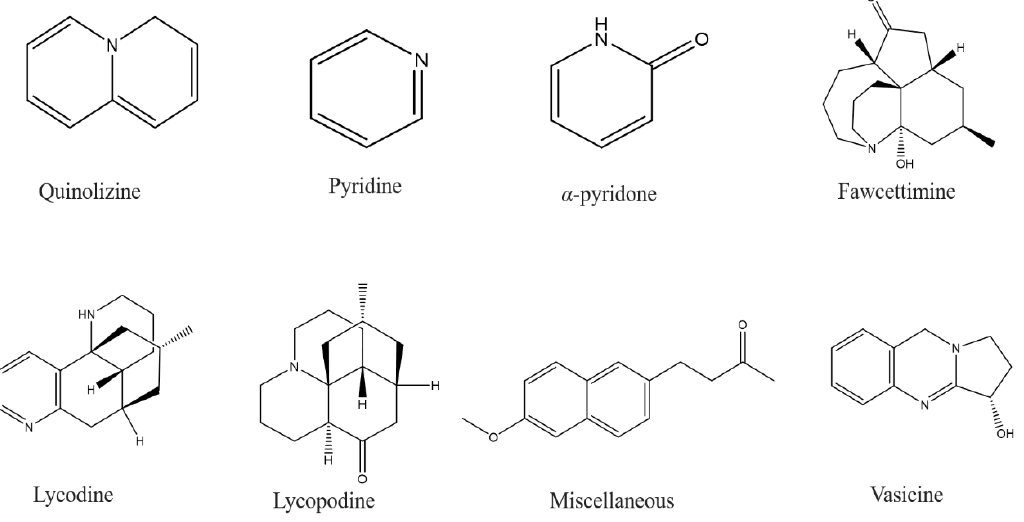
Figure 1. Structures of alkaloids with anti-Alzheimer effects.